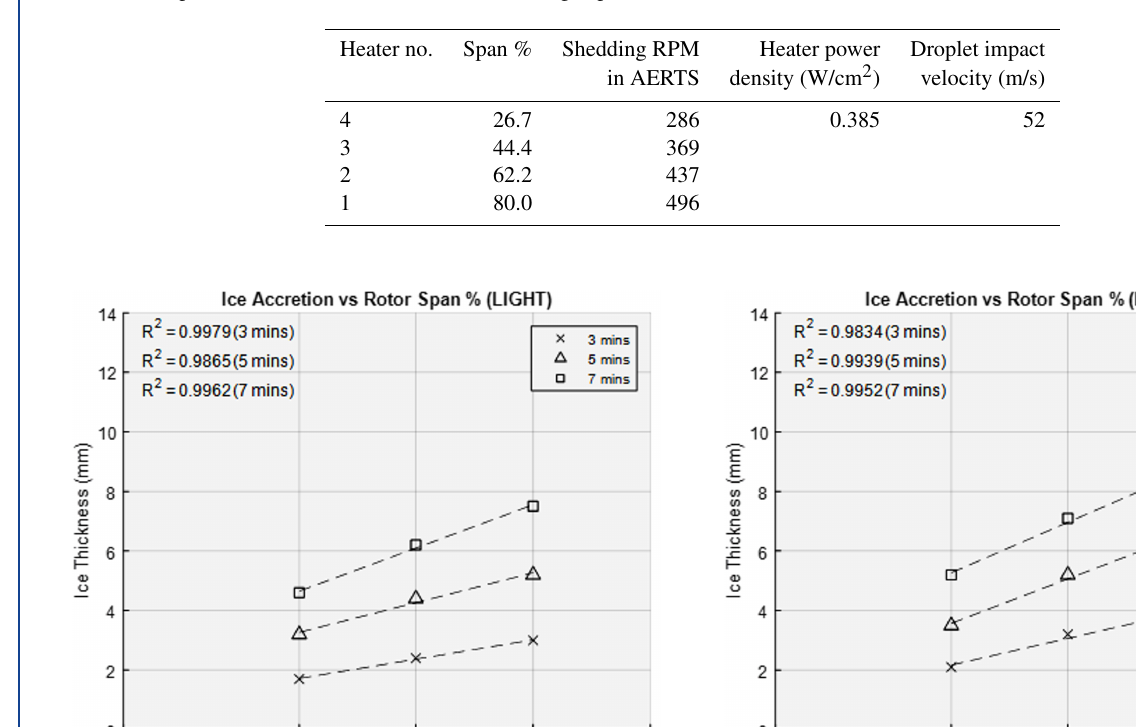
Table 3. Properties for minimum ice thickness shedding experiments.